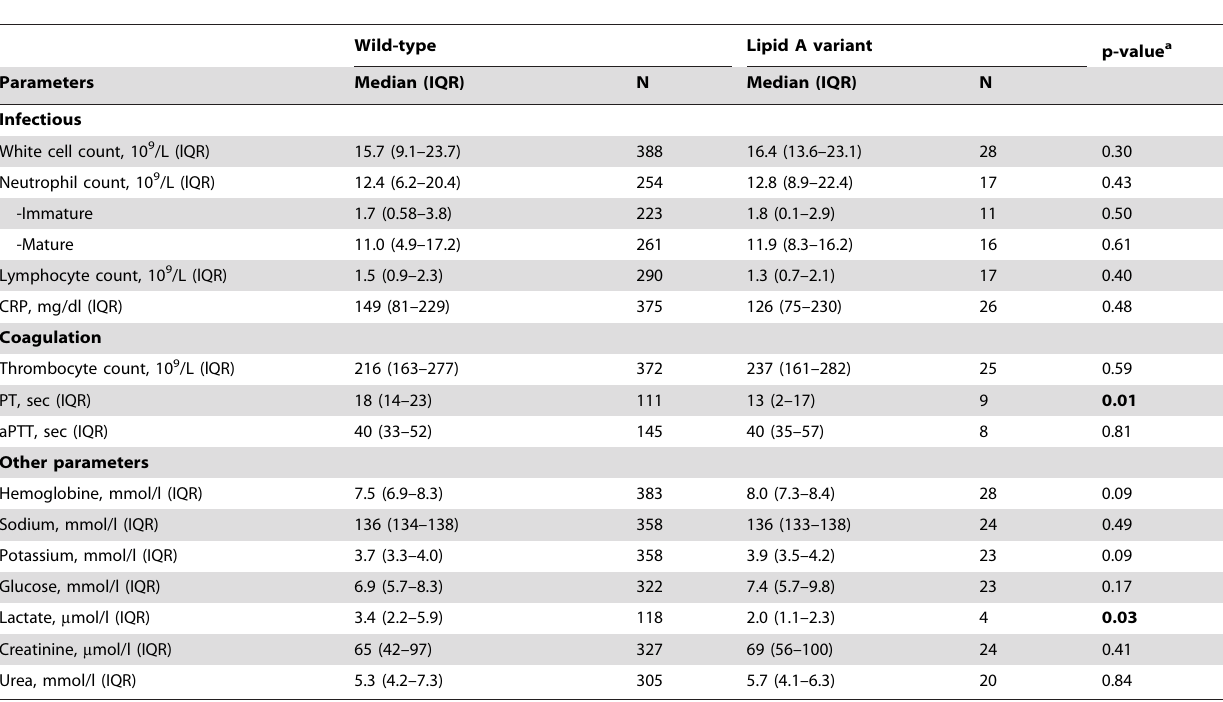
Table 4. Blood investigations within 12 hours after admittance in patients with meningococcal disease due to wild-type of lipid A variant strains.